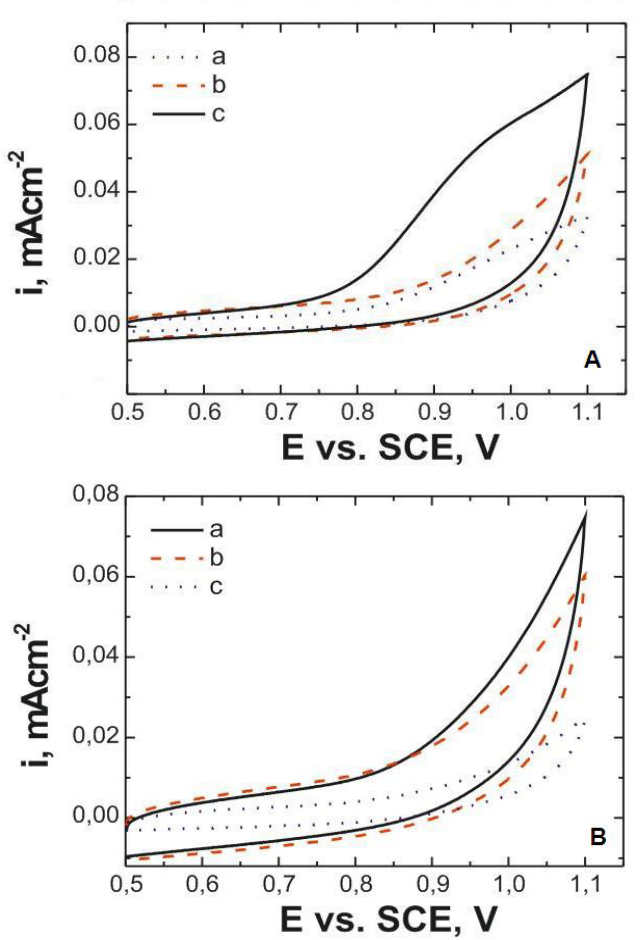
Figure 5. Cyclic voltammetric responses of 4-ABA films on glassy carbon electrode deposited: A - from the modification solution containing 4-ABA: (a) 5, (b) 10 and (c) 25, at t = 120 s; B – during (a) 240 s, (b) 480 s, (c) 1200 s (concentration of modification